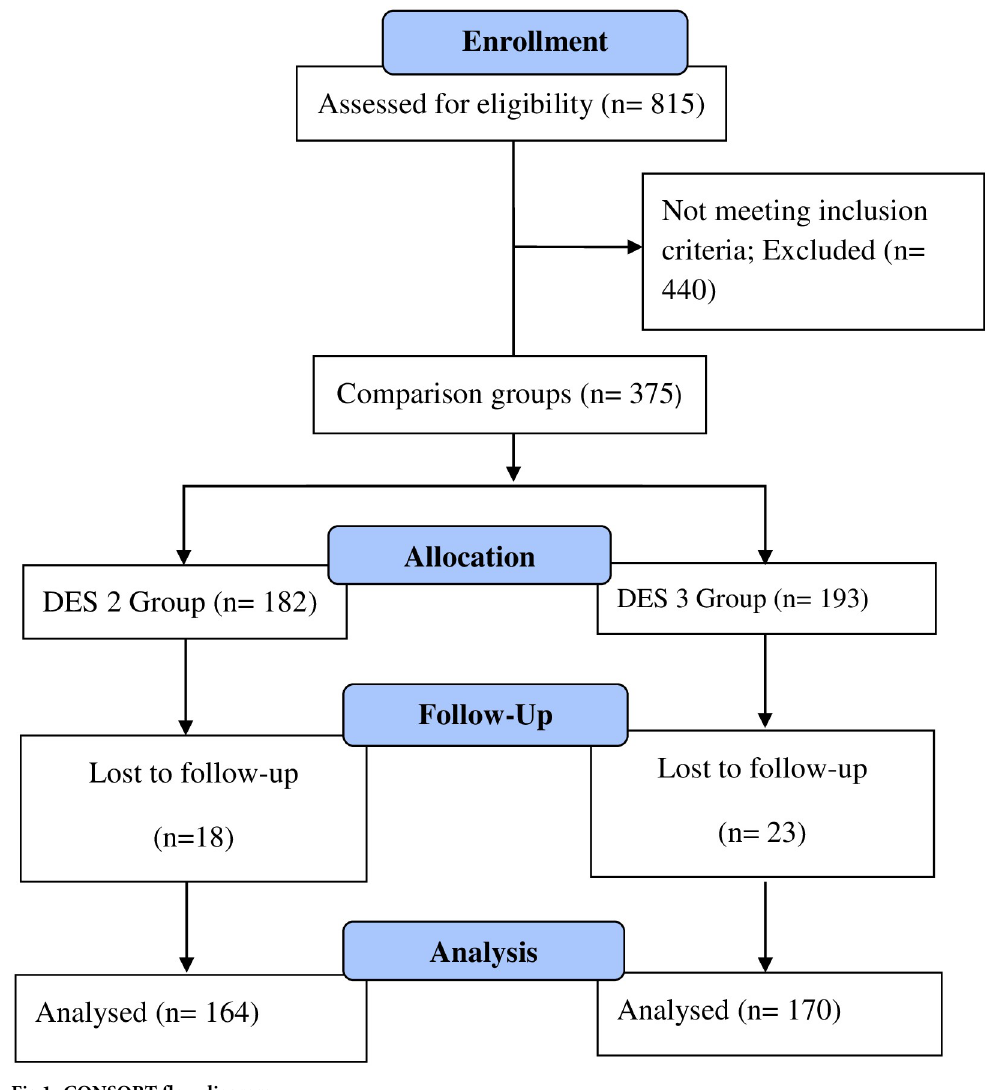
Fig 1. CONSORT flow